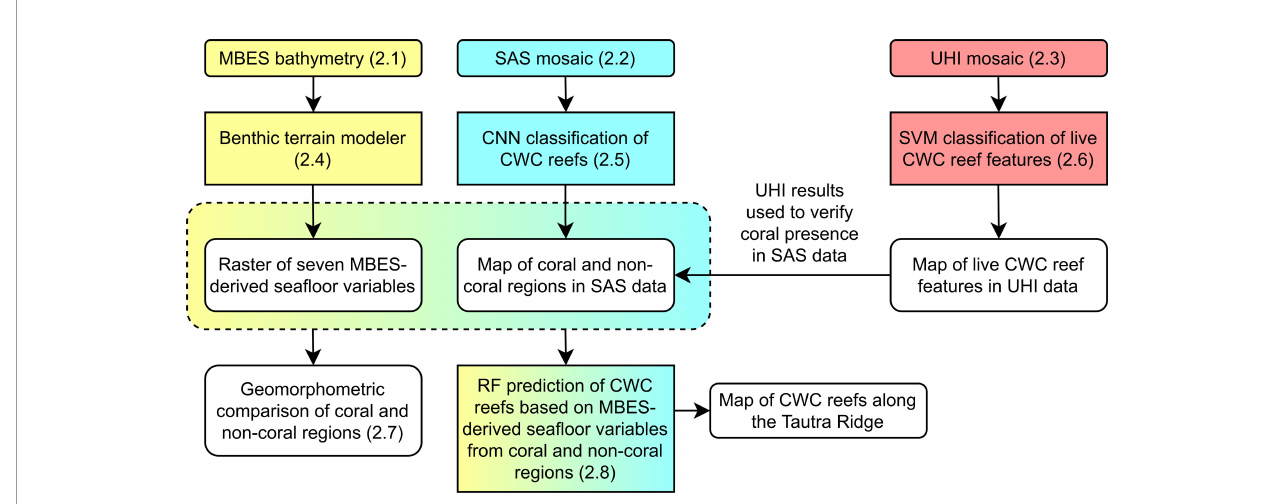
FIGURE 2 | Flowchart of the steps presented in the Materials and Methods Section (sections 2.1-2.8 ). CNN, convolutional neural network; CWC, cold-water coral; MBES, multibeam echo sounding; SAS, synthetic aperture sonar; SVM, support-vector machine; UHI, underwater hyperspectral